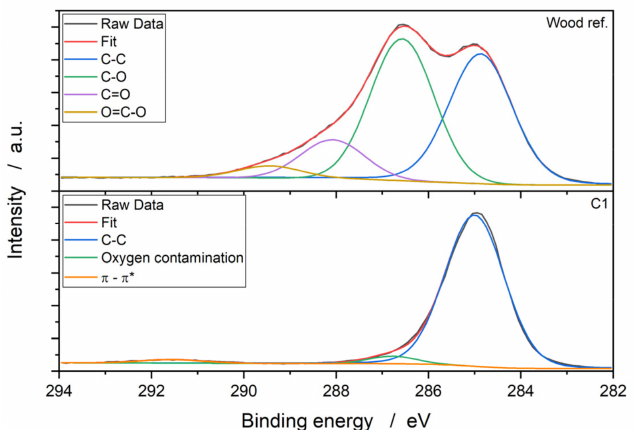
Figure 3. XPS carbon detail spectra of the uncoated wood reference and the parylene C1 coating ( n =